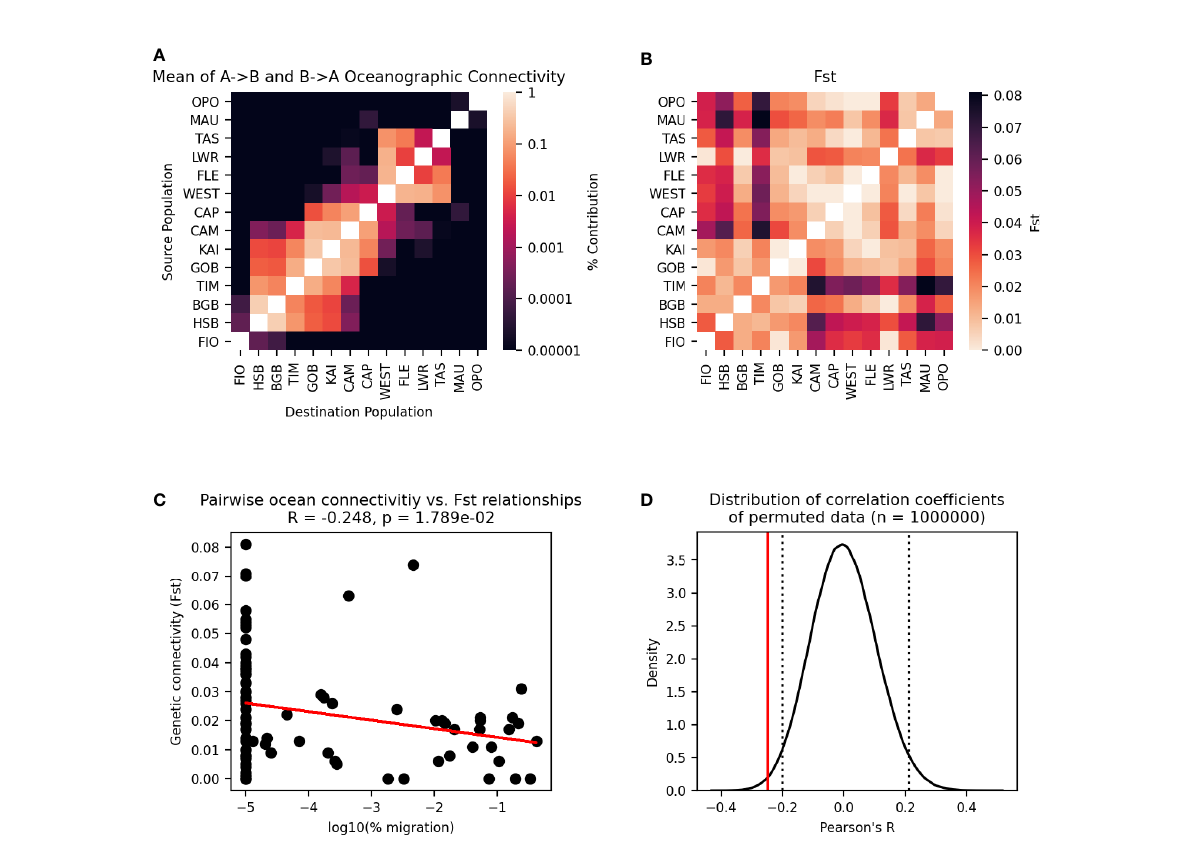
FIGURE 9 Permutational Mantel test between migration matrix generated by Lagrangian particle tracking model and pairwise F ST. (A) Particle tracking migration matrix, transformed for comparison to the pairwise F ST matrix — the mean of migration matrix values A ! B and B ! A is taken for each pair of populations, and the diagonal has been excluded. (B) Pairwise F ST matrix. (C) Pairwise relationships between cells in one triangle of the two matrices are plotted as points, with a line showing the best fi t of the data. Pearson ’ s correlation coef fi cient and p-value of the correlation are given. (D) The distribution of correlation coef fi cients between the migration matrix and 1,000,000 permutations of the pairwise F ST matrix. Dotted lines enclose 95% of the distribution, and the solid line shows the correlation coef fi cient of the unpermuted